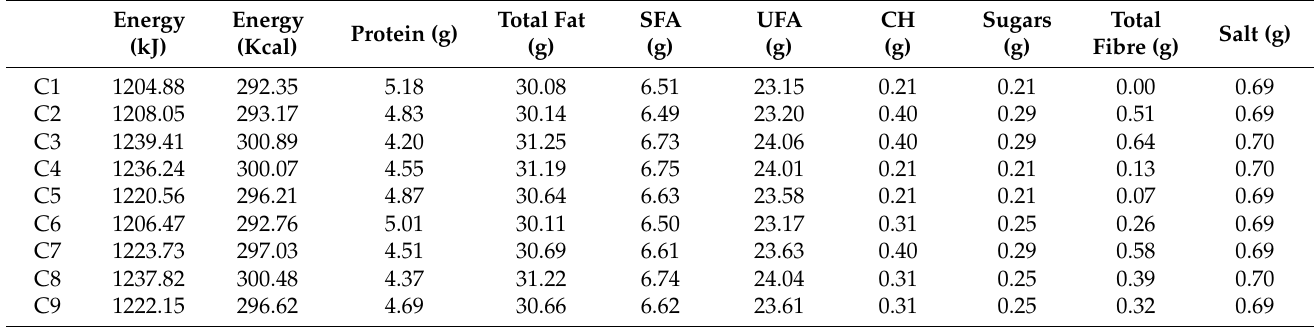
Table 4. Theoretical nutritional profiles of the nine spreadable cheese analogues. The samples, labelled from C1 to C9, contain different proportions of milk protein concentrate, faba bean protein concentrate and insect flour (MPC/FBP/IF): C1 (100/0/0), C2 (50/50/0), C3 (0/50/50), C4 (50/0/50),